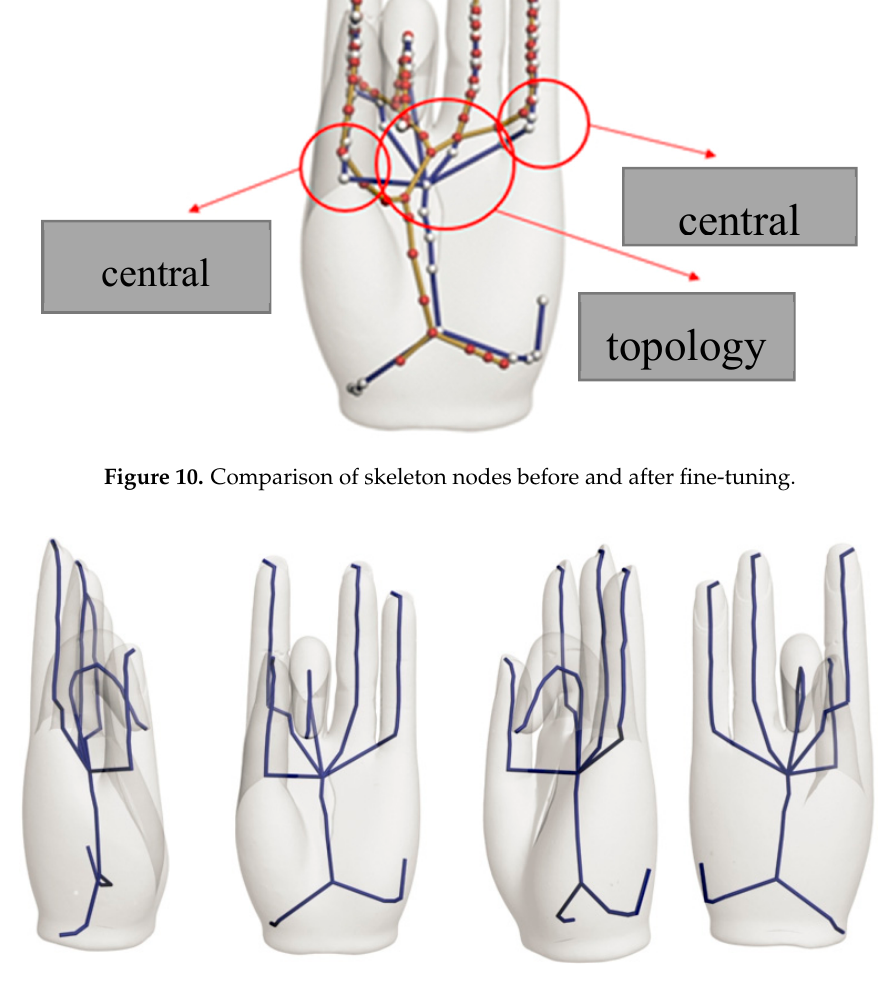
Figure 11. Multiangle displays of skeleton lines.